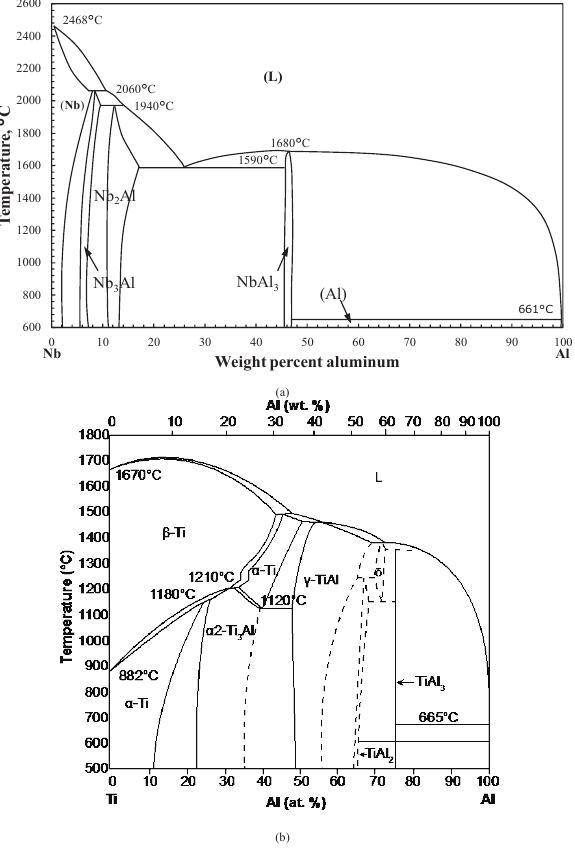
Figure 1: Phase diagram (a) Nb-Al, (b) Ti-Al [20].